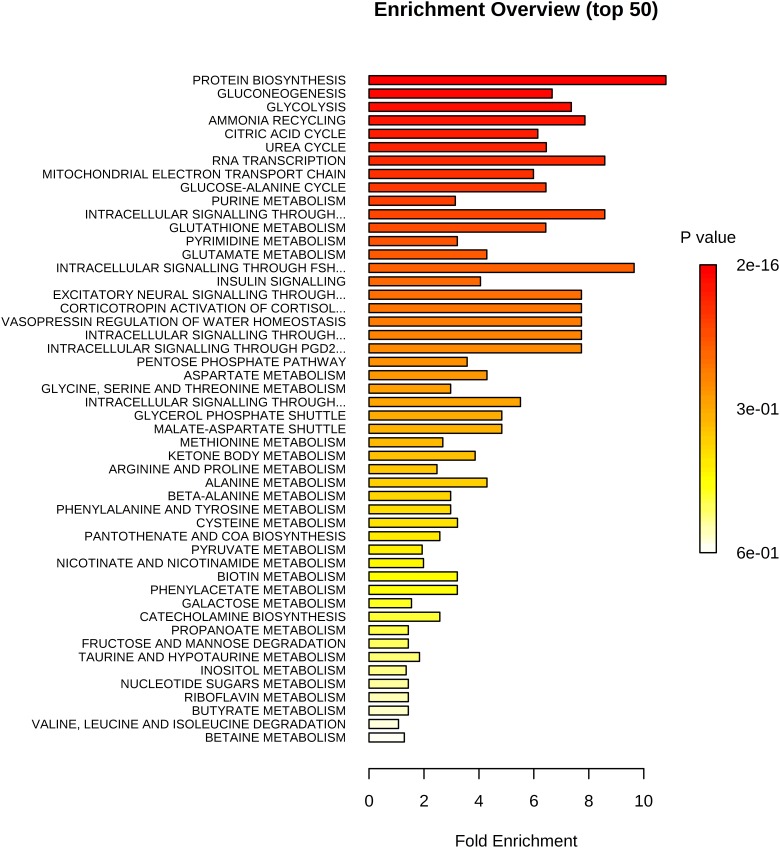
Enrichment analysis of 74 metabolites. Highest enrichment was found for protein biosynthesis (16/19) followed by gluconeogenesis (14/27) and glycolysis (12/21).